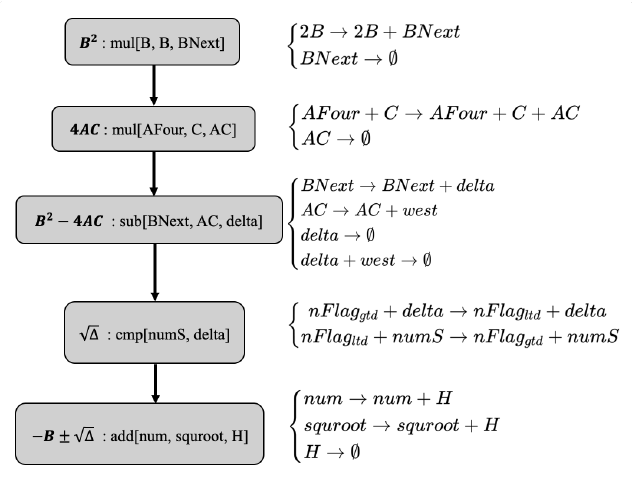
Figure 4. Dynamic simulation of the results of solving 2 a 2 x − 5 a x − 12 = 0, a = 2: ( a ) solving the square result of the integer, corresponding to the solution of result of two values of H 1,2 , H 1 = 16.0318 (green), H 2 = 0.00103034 (blue); ( c ) solution result of t 1 = 4 (orange), t 2 (red); ( d ) solving the exponential equation to obtain x = 2.00001 (orange). The abscissa represents the time unit is seconds.